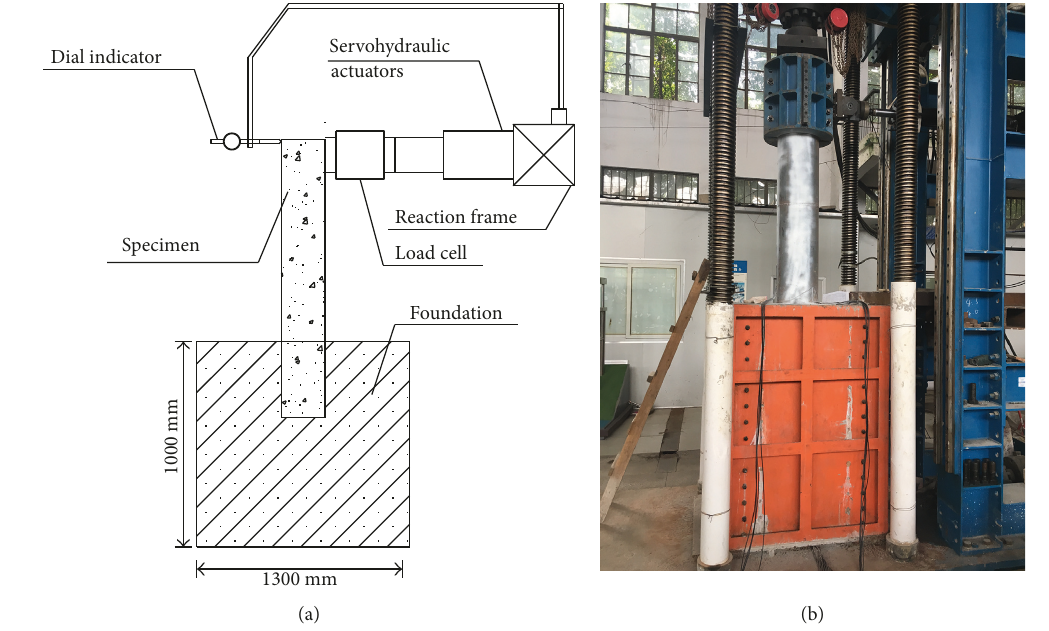
Figure 5: Test setup and instrumentation of